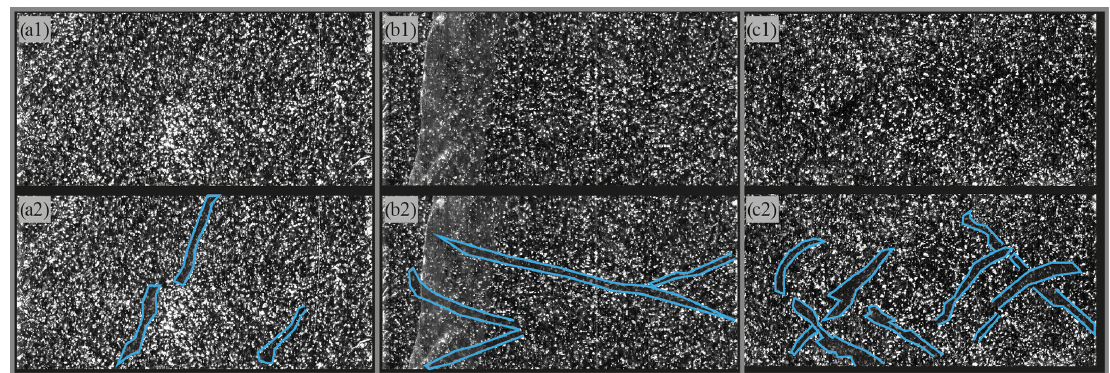
Figure A9. (a1, b1, c1) Line scan images and (a2, b2, c2) the same images as in the top row but with sloping bubble-free layers highlighted. (a) 459.60m, 3840 years b2k, very steep structures, melt-pipe-like appearance. (b) 696.26m, 5886 years b2k, continuous bubble-free struc- ture appearing as a set of conjugate deformation bands. (c) 998.73m, 8625 years b2k, many sloping bubble-free layers that are all at angles of around 45 ◦